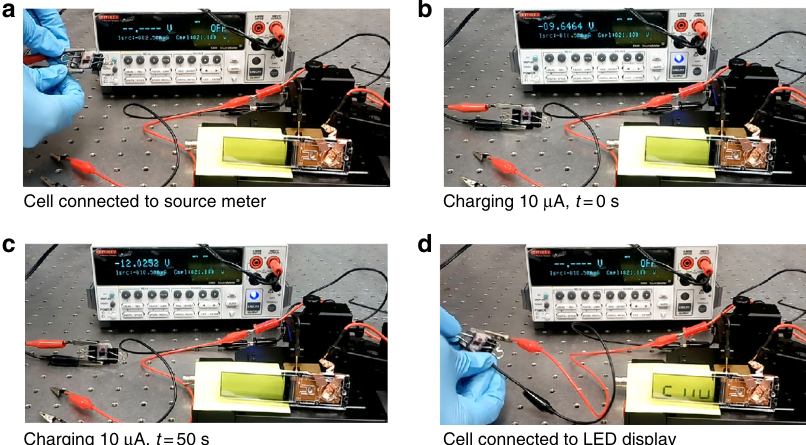
Fig. 6 Storage of externally injected charges by a single biophotonic power cell. a A single-biophotonic power cell (BPC) with RC-LH1 (reaction centre-light harvesting 1 complexes) was connected to source meter. b Charge was injected into the cell by applying a constant current of 10 μ A. c The cell was charged for 50 s. d The charged cell powered an LED display for approximately